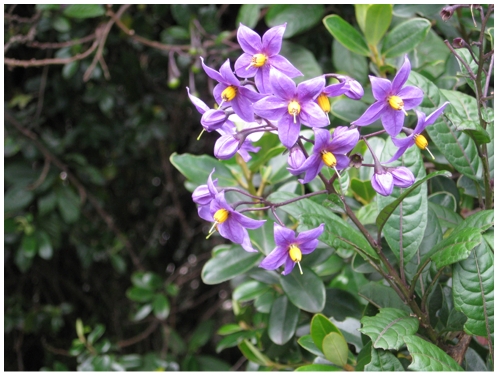

Solanum sanchez-vegae.Peru. La Libertad. A. Cano s.n. (photograph courtesy of A. Cano, USM).